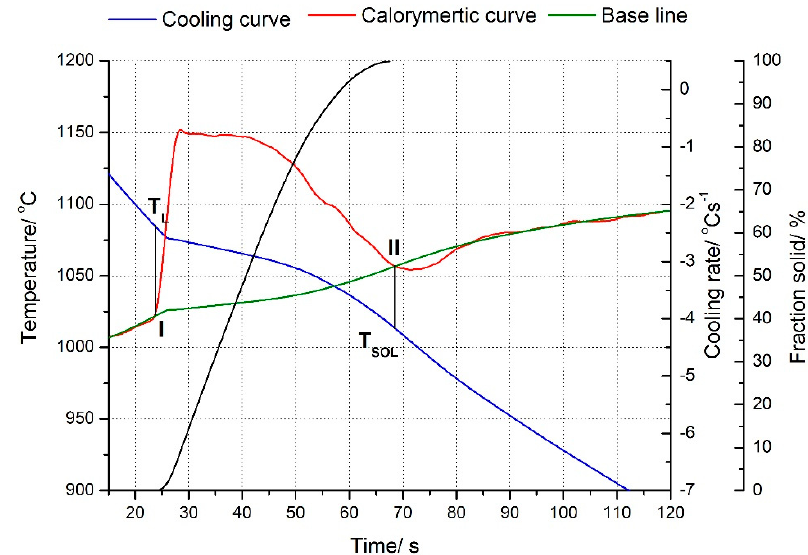
Figure 2. Cooling and derivative curves for Cu–2Ni–1Si–0.6Re alloys. Solid fraction during the crystallization of the particular compounds of Cu–2Ni–1Si–0.6Re alloy. Freely cooled alloy, cooling rate 1.5 °C s − 1 . Table 2. Results from thermal-derivative analyses of Cu–Ni–Si–Cr and Cu–Ni–Si–Cr–Re alloys.